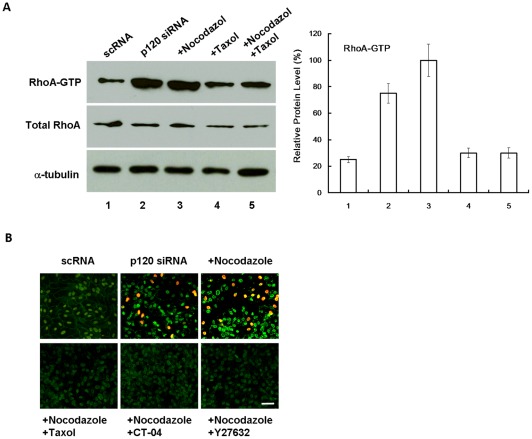
RhoA-ROCK signaling controls nuclear p120 translocation and BrdU labeling.(A) The level of active RhoA was promoted 5-fold by p120 siRNA and 7-fold with addition of nocodazole. The level of active RhoA promoted by p120 siRNA or p120 siRNA+nocodazole was inhibited by taxol to the baseline. (B) Nuclear BrdU labeling and p120 staining promoted by p120 siRNA+nocodazole was abolished by Taxol, CT-04 (RhoA inhibitor), or Y27632 (ROCK inhibitor). Scale bar indicates 100 μm.